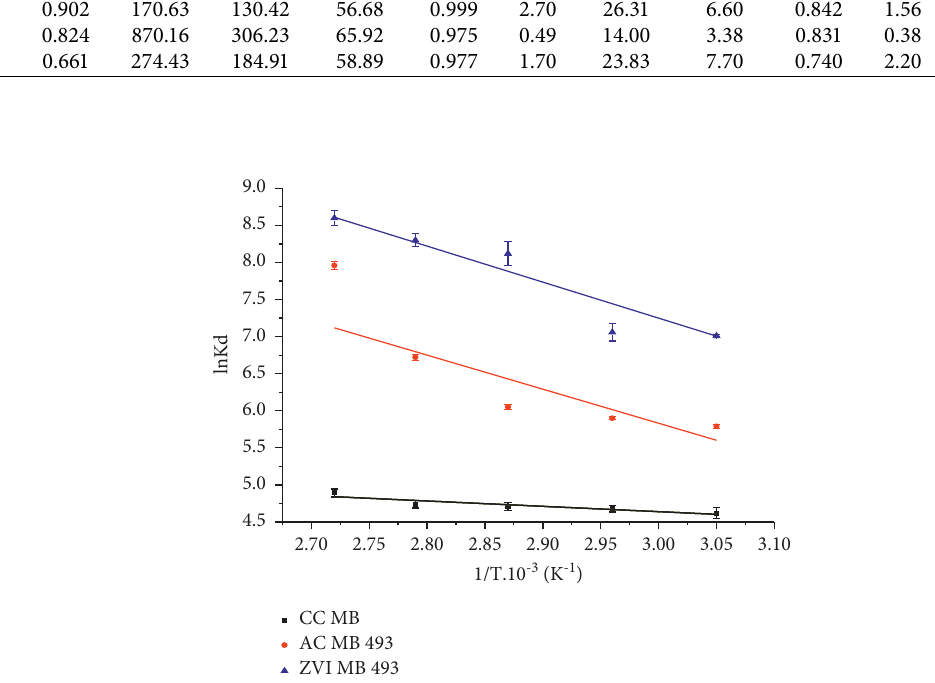
Table 5: The error functions parameters of β -carotene adsorption onto CC MB, AC MB 493, and ZVI MB 493 at 95 ° C. Pseudo-first-order Pseudo-second-order Diffusion intraparticle Adsorbents